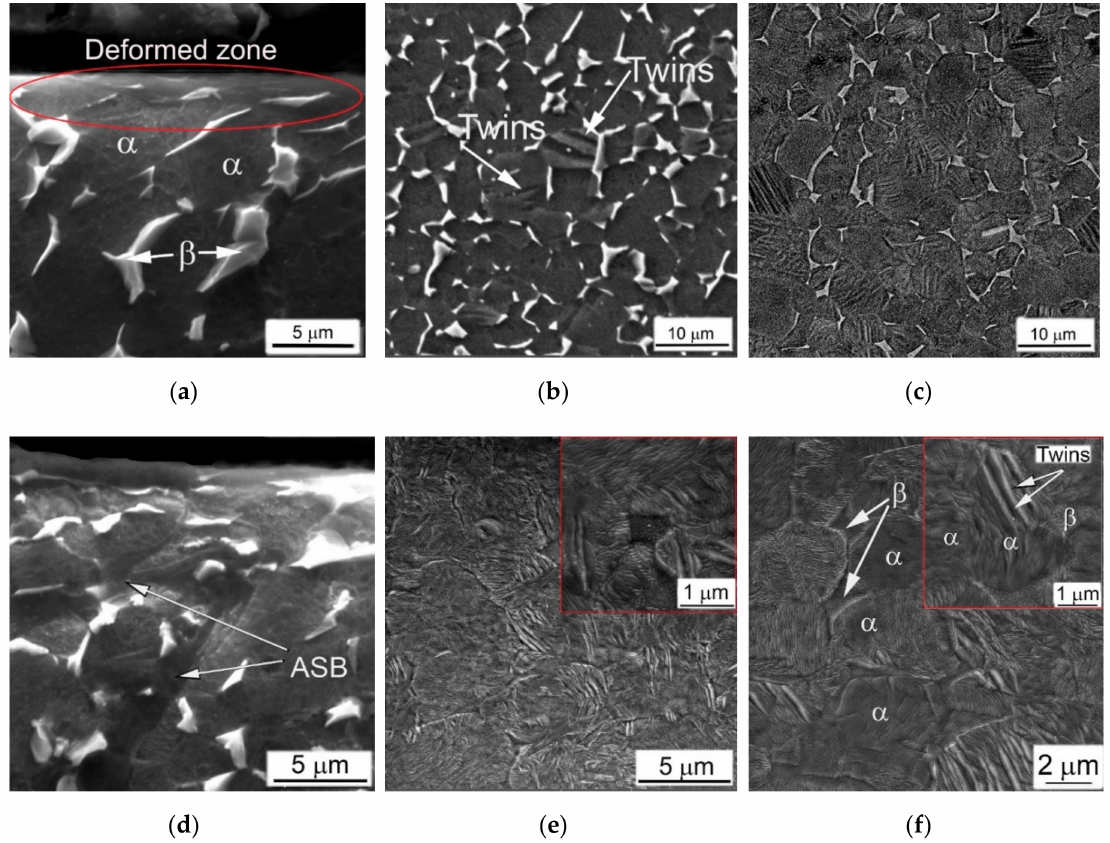
Figure 10. SEM images of Ti64GL specimens after the dynamic tests at the following strain rates: ( a,b ) 2100 s − 1 ; ( c ) 2500 s − 1 ; ( d – f ) 2660 s − 1 —( a,d ) show zone I; ( b , c )—zone IV; ( e , f )—zone III; (images ( a,b , d – f ) are taken in SE mode from the etched surface, whereas image ( c ) is in the BSE (back scattered electrons) mode from just polished